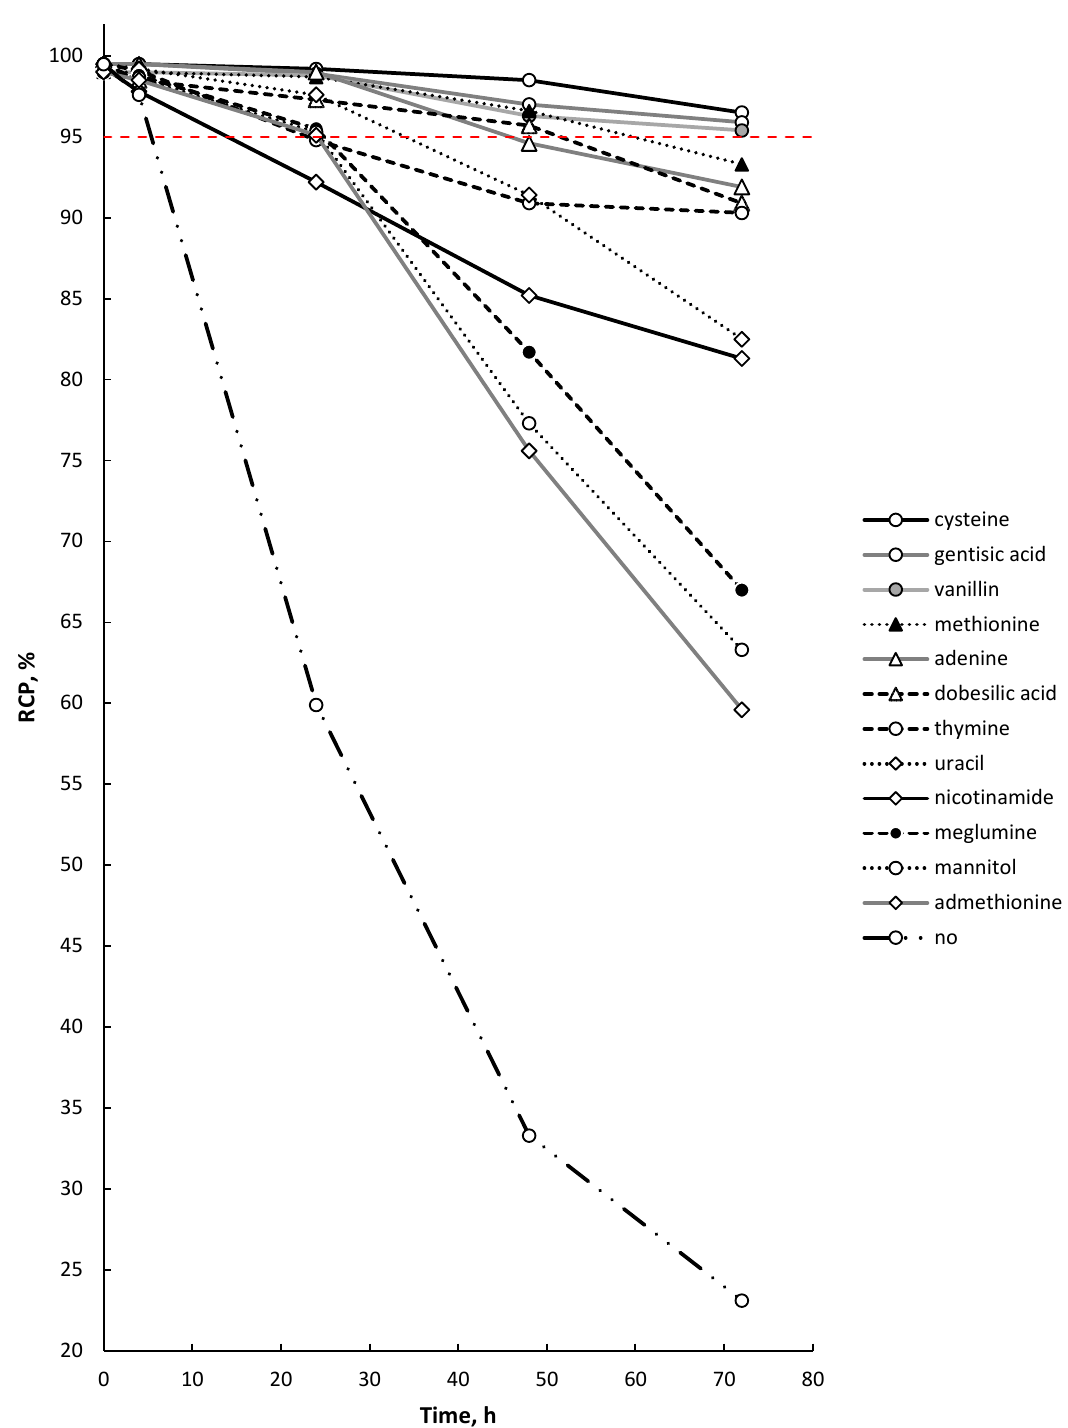
Figure 12. Influence of various quencher additions on the maintenance of [ 177 Lu]Lu-PSMA-617 radiochemical purity over time. Samples volume—1 mL, 177 Lu activity in the sample—450 MBq, pH 4.5, synthesis at 95 °C for 30 min, 100 μ g of PSMA-617 C(Na-acetate) = 0.03 mol/L (RCP value is presented as mean, n = 3; error bars are omitted for clarity).